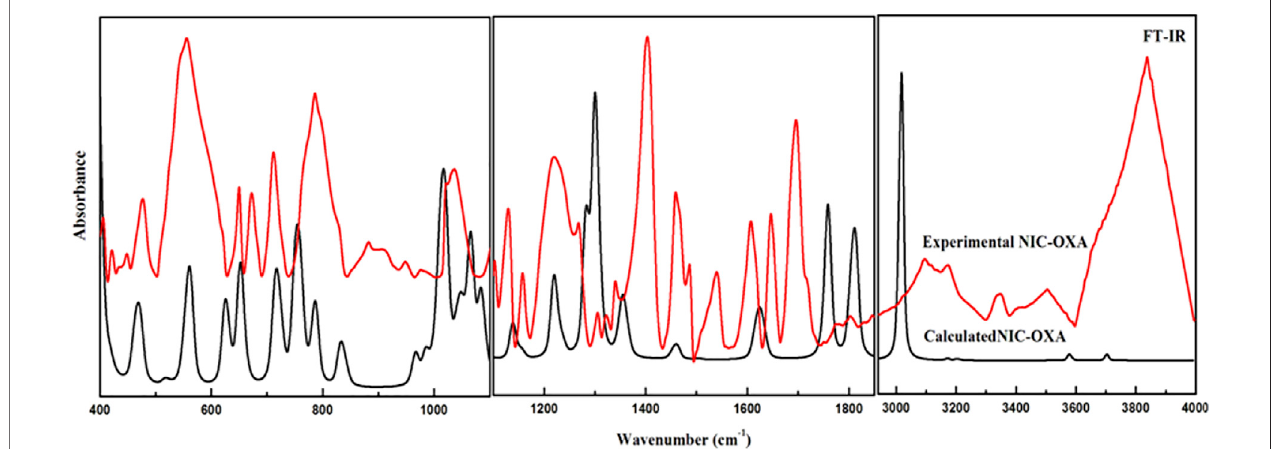
FIGURE 2 | Experimental and calculated FT-IR absorbance spectra of NIC – OXA salt in the region of 400 – 4,000 cm − 1 . FT-IR, Fourier transform IR; NIC – OXA, nicotinamide – oxalic acid.